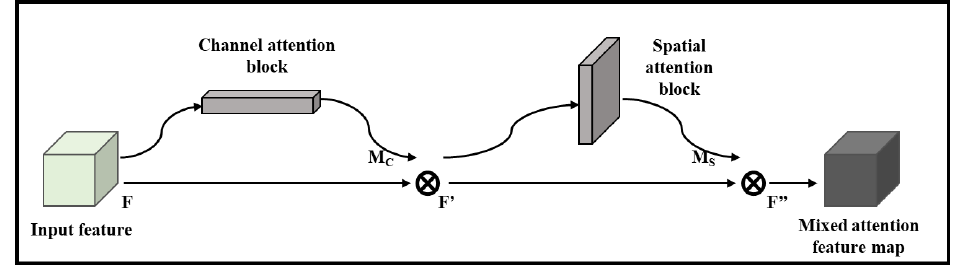
Figure 6. Structure of the proposed mixed visual attention